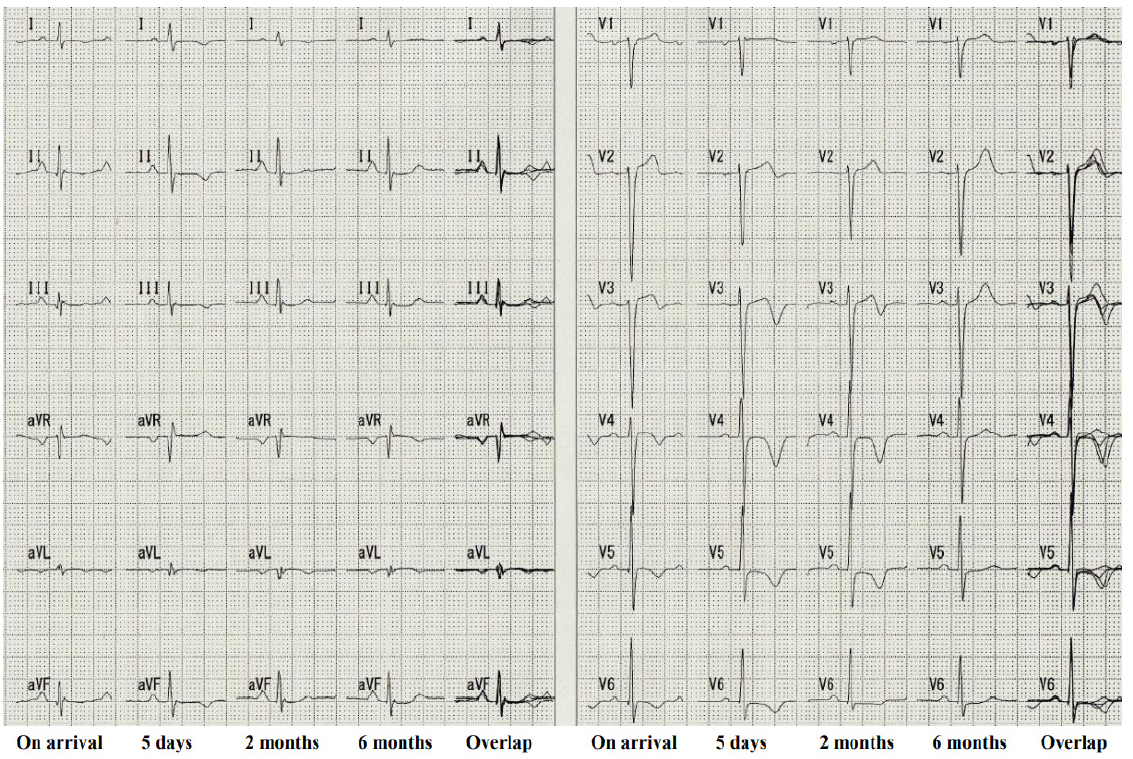
Figure 4. The time course of ECG changes from the patient’s admission to the 6-month follow-up. The overlap ECG waveform in each lead is presented on the right. Reconstructed from [82].